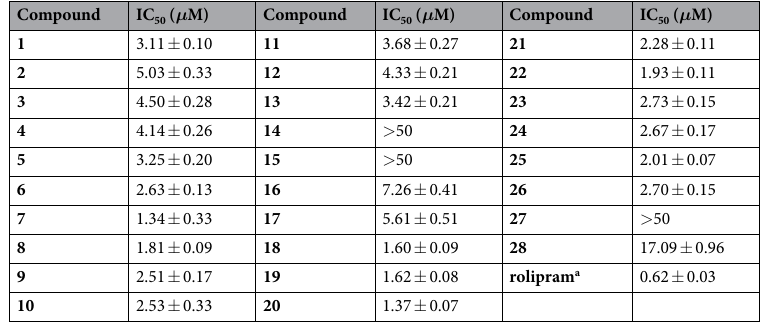
Table 6. IC 50 Values of compounds against PDE4D2. a Positive